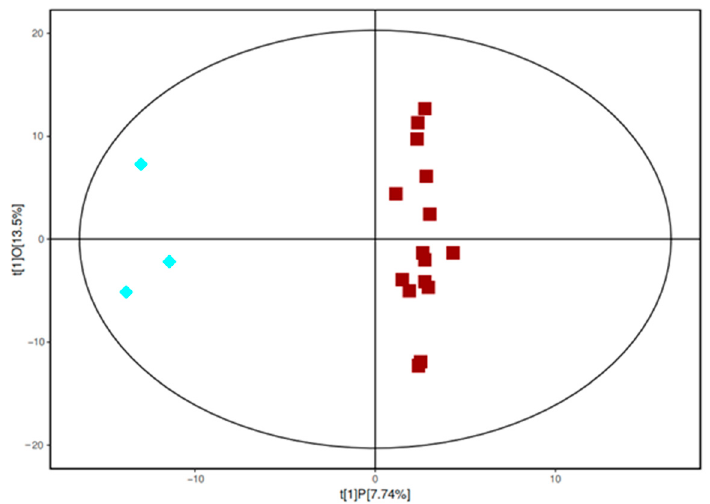
Figure 2. The OPLS-DA model of the sixth accumulative temperature zone (blue diamonds) and the other accumulative temperature zone samples (red squares).